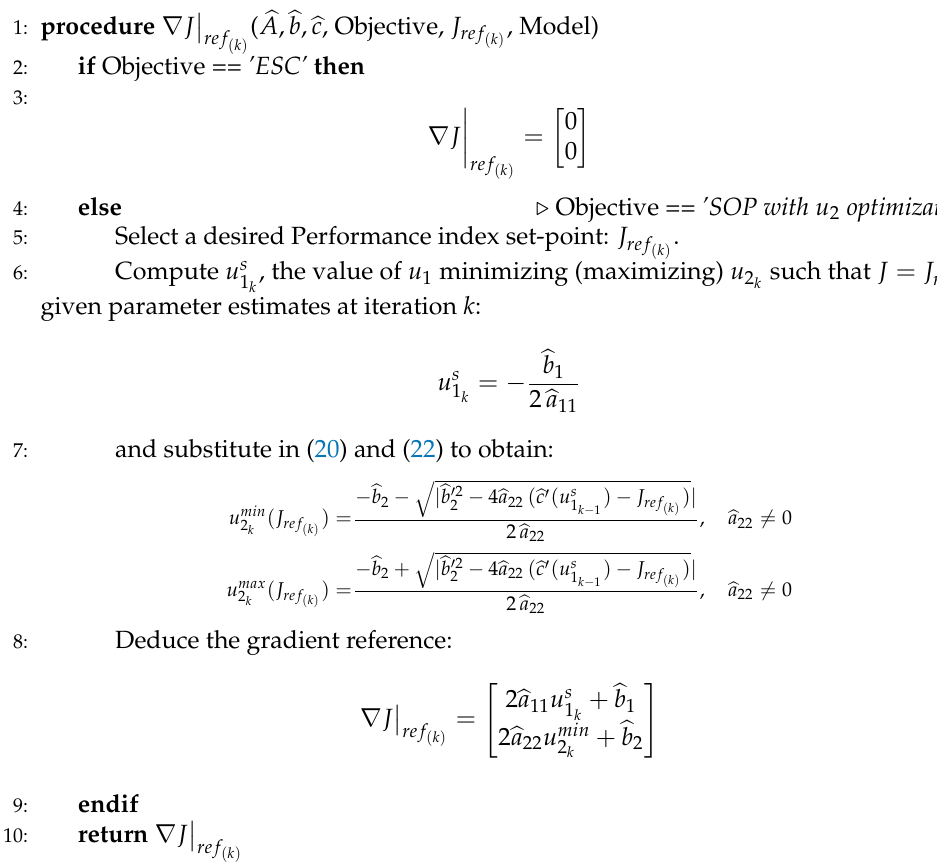
Algorithm 1 Adaptive slope reference generation algorithm for DISO processes ESC and SOP with minimization/maximization of one input